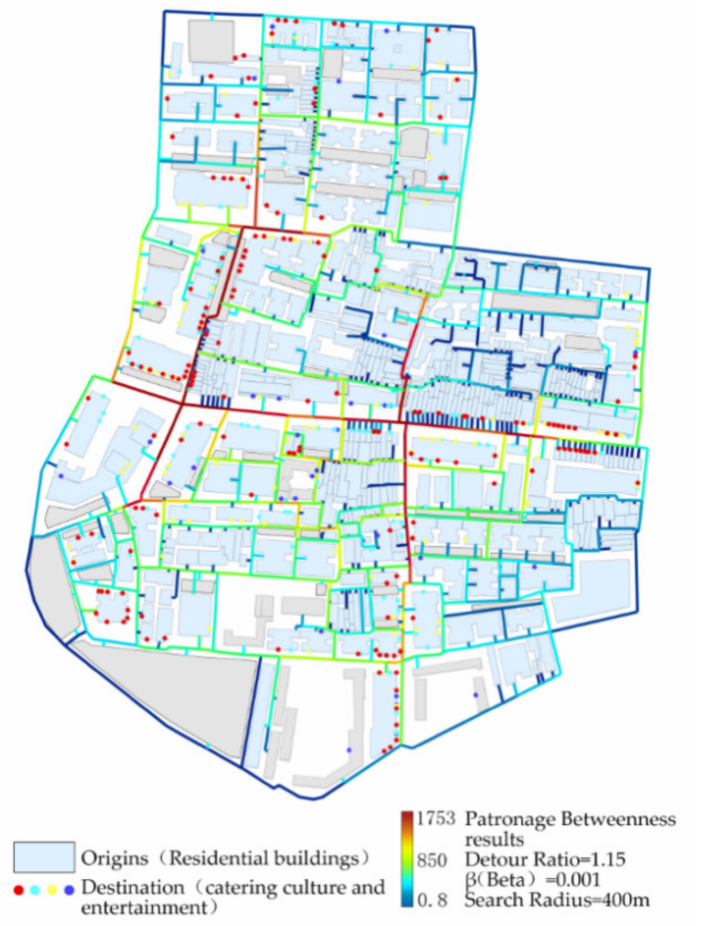
Figure 8. Simulation result of pedestrian flow distribution from residential buildings to commercial